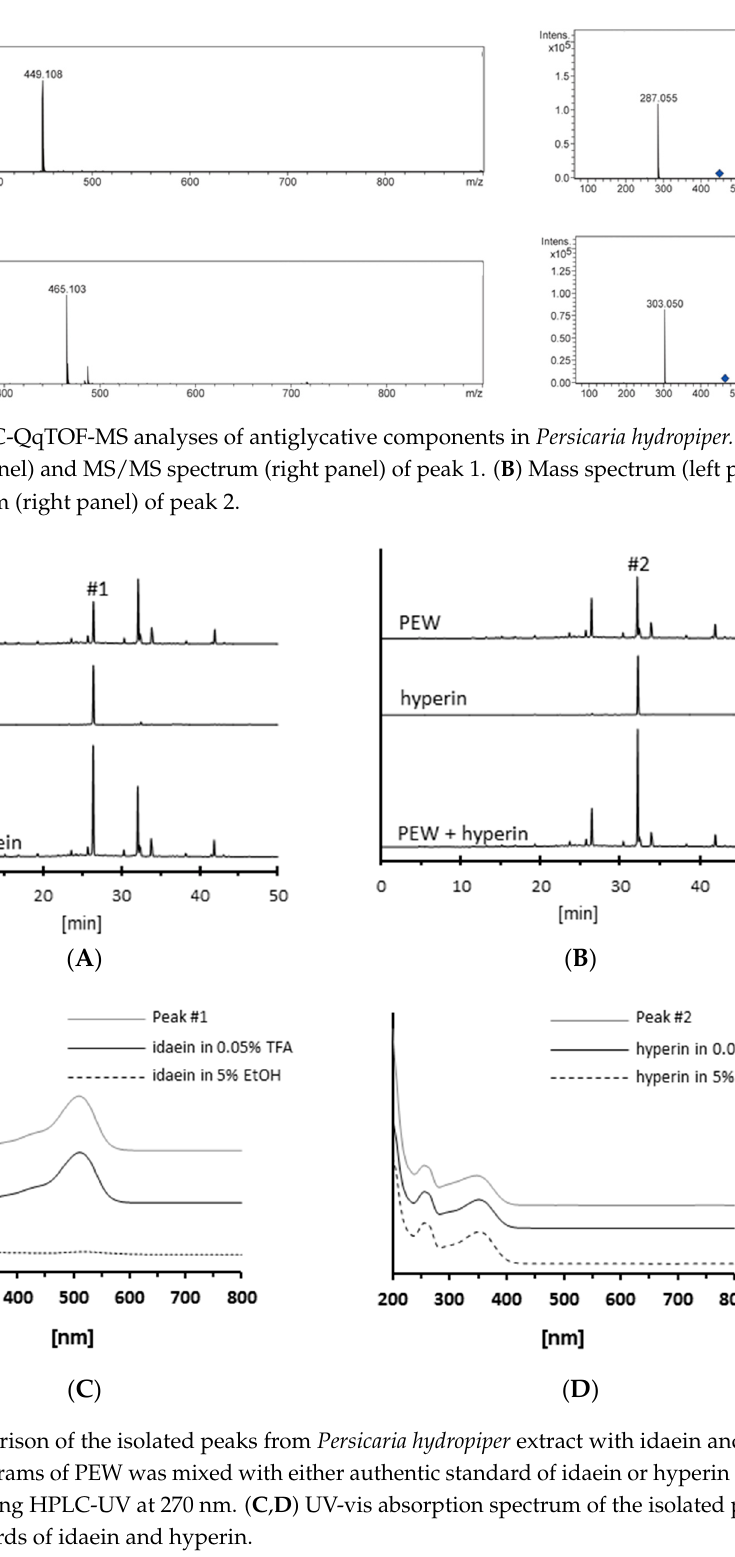
Figure 4. UHPLC-QqTOF-MS analyses of antiglycative components in Persicaria hydropiper. ( A ) Mass spectrum (left panel) and MS/MS spectrum (right panel) of peak 1. ( B ) Mass spectrum (left panel) and MS/MS spectrum (right panel) of peak 2.